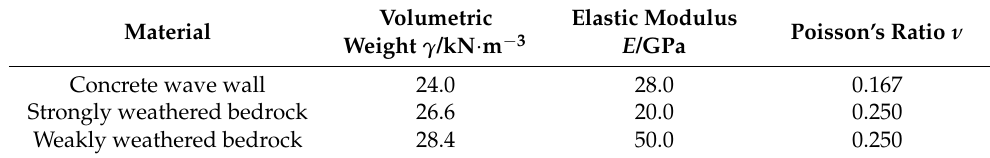
Table 3. Calculation parameters for linear elastic model materials.